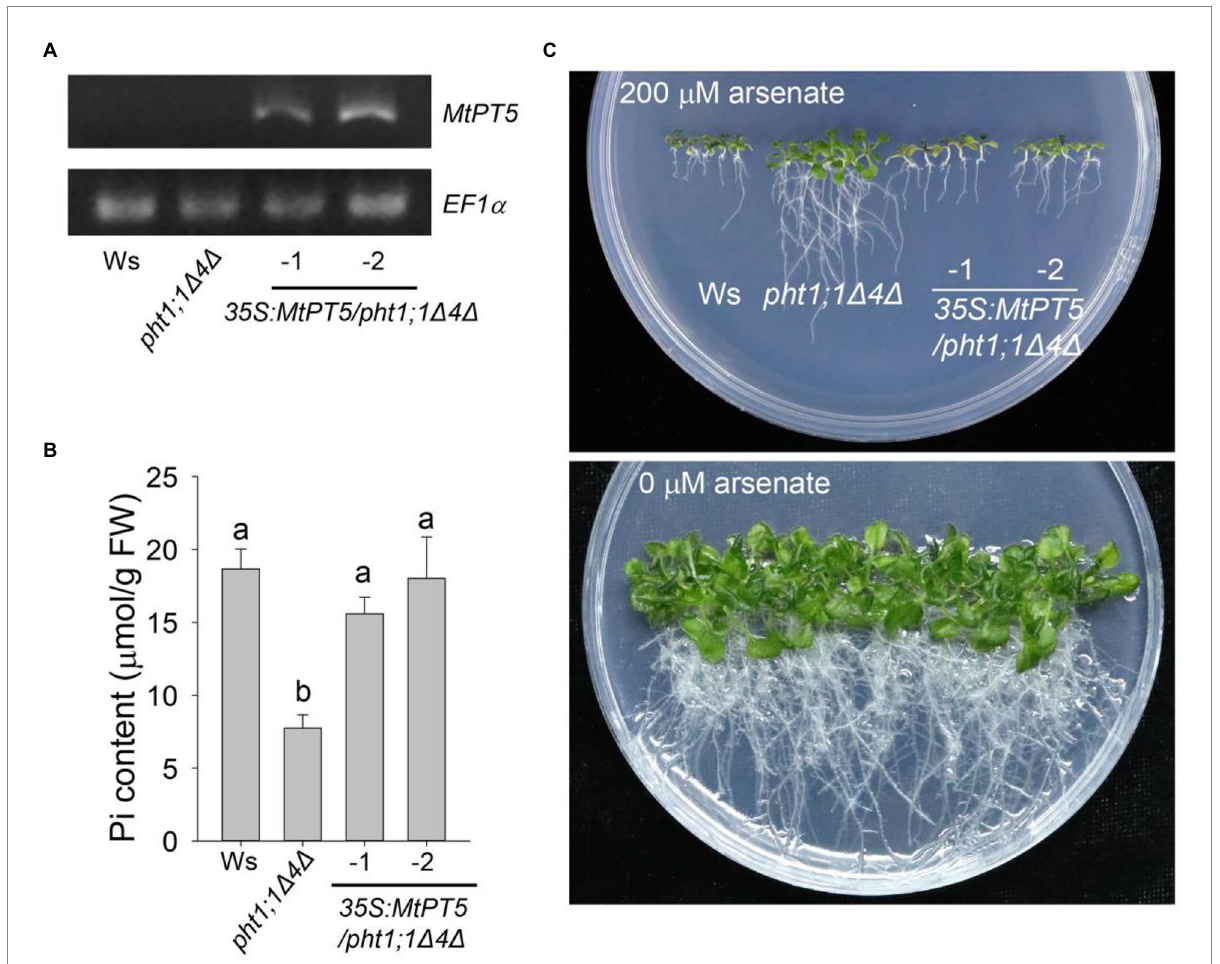
FIGURE 3 Ectopic expression of MtPT5 enhanced Pi acquisition in Arabidopsis . (A) RT-PCR analysis of MtPT5 in wild-type Arabidopsis (Ws), pht1;1 Δ 4 Δ double mutant and 35S:MtPT5 / pht1;1 Δ 4 Δ transgenic plants using MtPT5 -specific primers. The housekeeping gene EF1 α was used as an internal control. (B) Pi content measurement of wild-type Arabidopsis (Ws), pht1;1 Δ 4 Δ double mutant and 35S:MtPT5 / pht1;1 Δ 4 Δ transgenic plants. The whole seedlings grown on 1/2 MS for 20 days were collected for Pi extraction. Data represent mean ± SE ( n = 3). Different letters indicate significant difference at p < 0.05 (One-way ANOVA, Tukey test). (C) Image of wild-type Arabidopsis (Ws), pht1;1 Δ 4 Δ double mutant and 35S:MtPT5 / pht1;1 Δ 4 Δ transgenic plants grown on 1/2 MS containing 200 μ M arsenate or without arsenate for 20